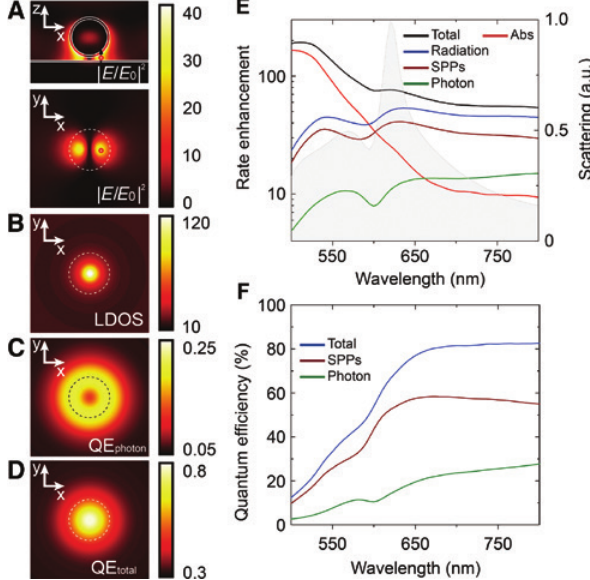
Figure 2: Electric field enhancement, LDOS enhancement, and QE in the nanogap underneath the SiNP. (A) Simulated electric field enhancement distributions in the cross- sectional plane (upper panel) and the quantum dot monolayer plane (lower panel) of the SiNPoM at the excitation wavelength of 532 nm where the dashed line represents the projection area of the SiNP with the diameter of 174 nm and the Al thick. (B–D) Simulated maps of the LDOS enhancement relative to a dipole in a vacuum space (B), the photon QE (C) and the total QE (D) as a function of dipole position under the SiNP at the